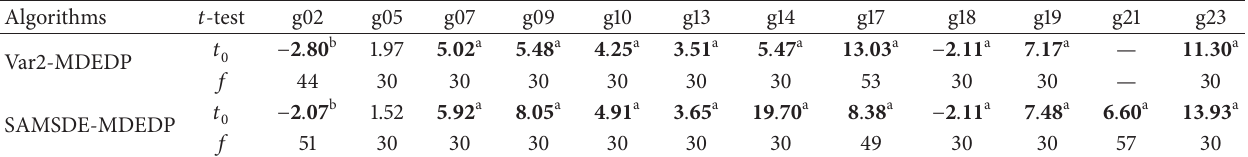
Table 4: Results of the approximate two-sample 𝑡 -test between the other two algorithms and our MDEDP for 12 instances. Algorithms 𝑡 -test Var2-MDEDP